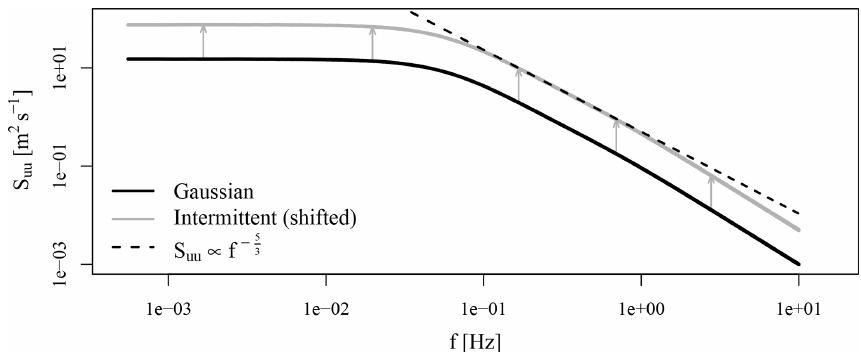
Figure 4. Power spectral density (PSD) S uu for the main wind velocity component u ( t ) for the Gaussian and intermittent field types. Note that the intermittent spectra are shifted by a factor of 5 for better representation. The length of the arrows corresponds to the distance of the shift. The dashed line represents a − 5 slope relevant to 3